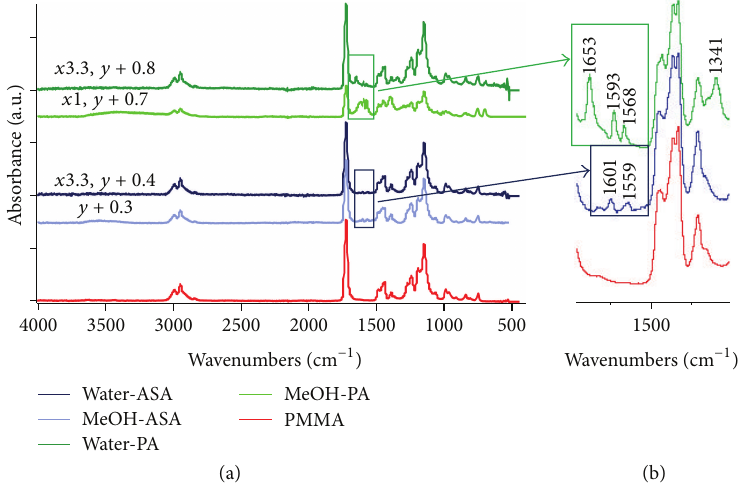
Figure 8: ATR infrared spectra (a) at 4000–500 cm −1 of undoped precipitated PMMA (red), ASA systems via water (dark blue) and via methanol (light blue), and PA systems via water (dark green) and via methanol (light green). (b) Inset: representation of peaks located at 1700–1500 cm −1 .